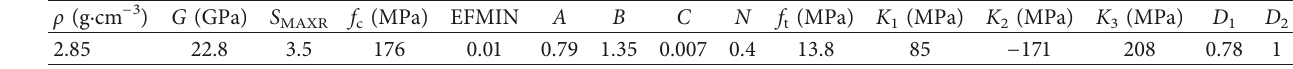
Table 6: HJC material model parameters for RPC [12].